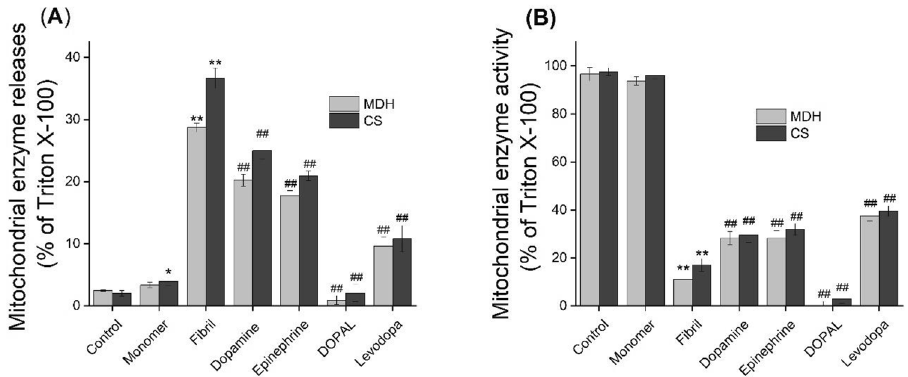
Figure 8. The effect of catechols on the α-syn aggregates-induced mitochondrial enzyme release ( A ) and enzyme activity inhibition ( B ). Mitochondrial suspensions (1 mg/mL) were incubated alone or with 20 µM α-syn aggregates, produced in the absence or presence of 200 µM catechols. Data are expressed as mean ± SD with n = 3. * p < 0.05, ** p < 0.01, significantly different from control. ## p < 0.01 significantly different from mitochondria exposed only to α-syn amyloid fibrils.